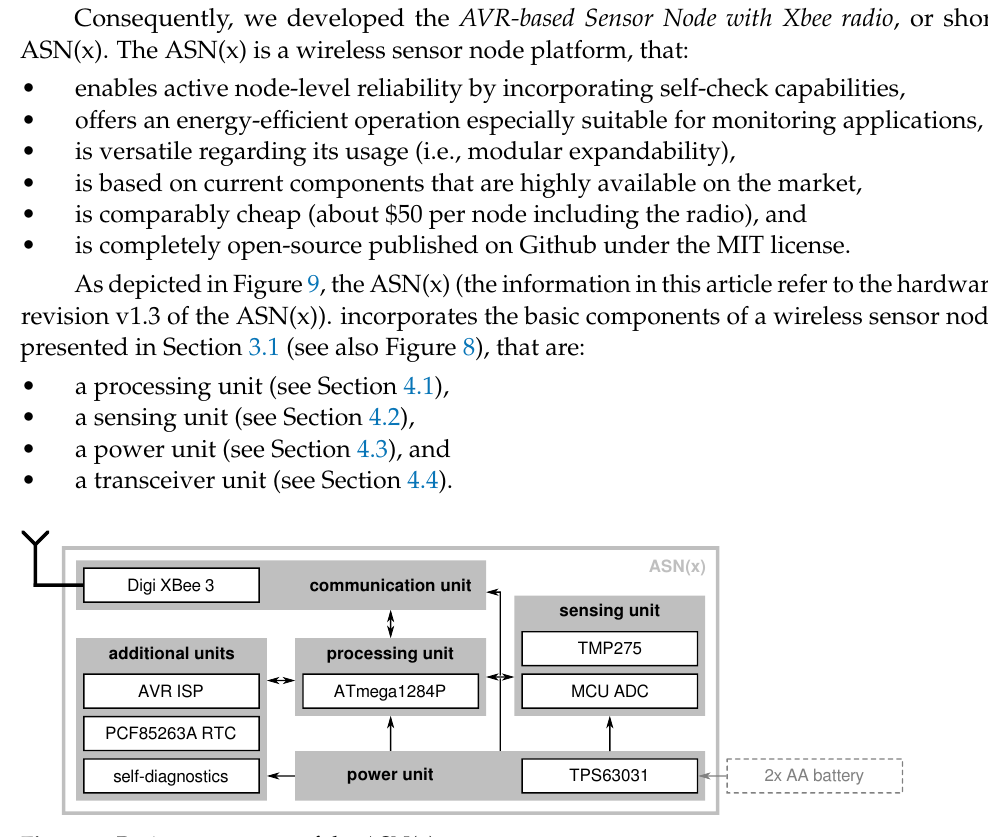
Figure 9. Basic components of the